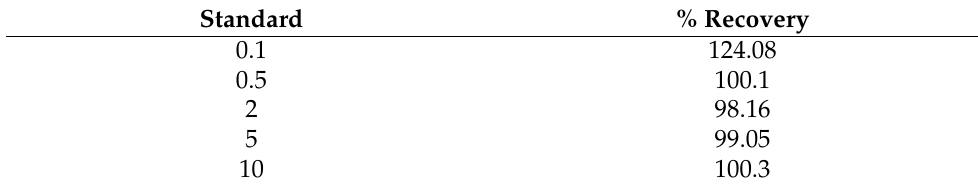
Figure 1. Citric acid standard calibration curve. Table 1 . Percentage recovery values of citric acid standard .